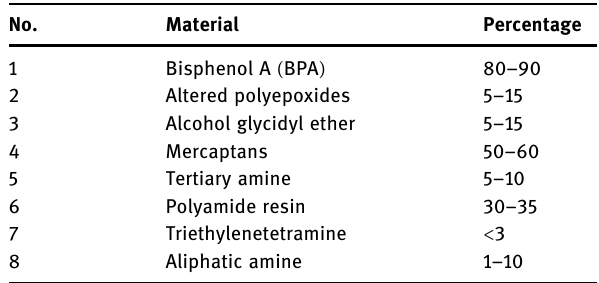
Table 2: Epoxy resin composition [ 21 ]